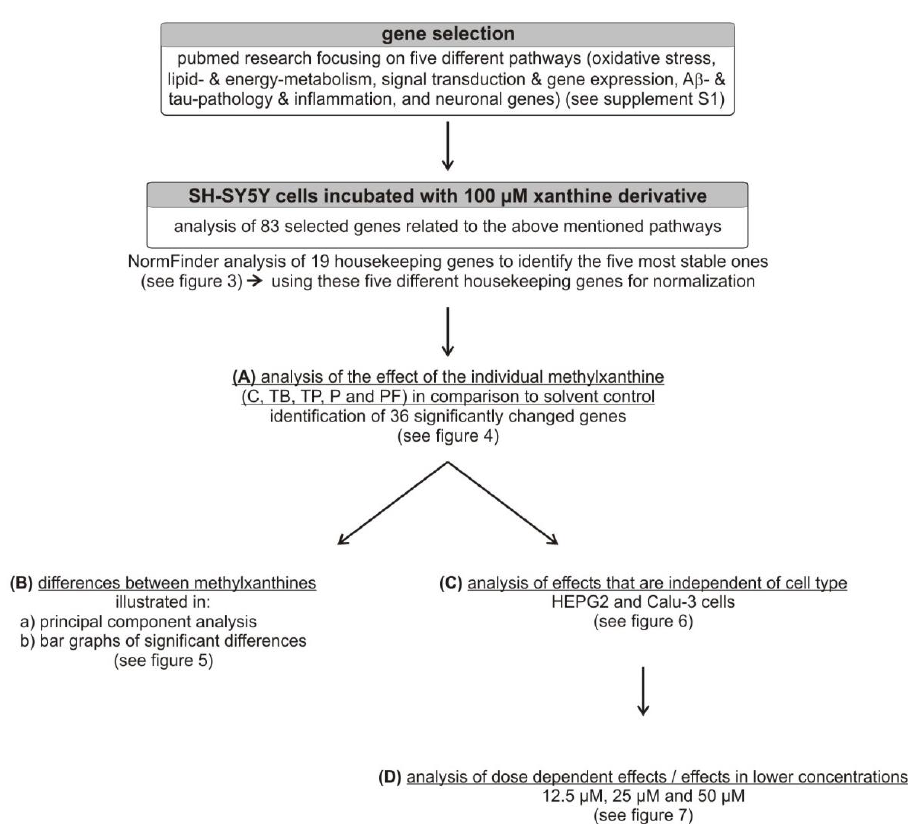
Figure 2. Design of the study. C: caffeine, TB: theobromine, TP: theophylline, P: pentoxifylline, PF: propentofylline.